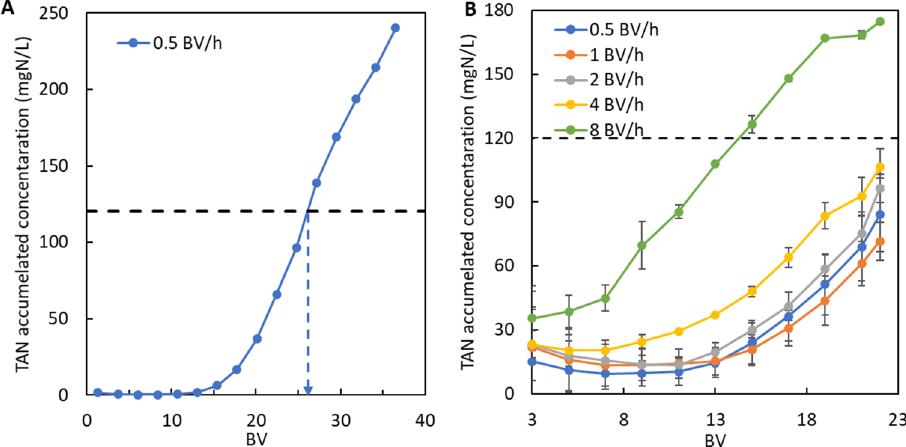
Figure 6. ( A ) shows the breakthrough curve of a preliminary experiment (0.5 BV/h, TAN = 640 mgN/L), and ( B ) breakthrough curves showing the average cumulative TAN concentration of adsorption effluent as a function of the flow rate for the selected retention times; 22 BV, repetitions ( n ) = 3, and ambient temperature.